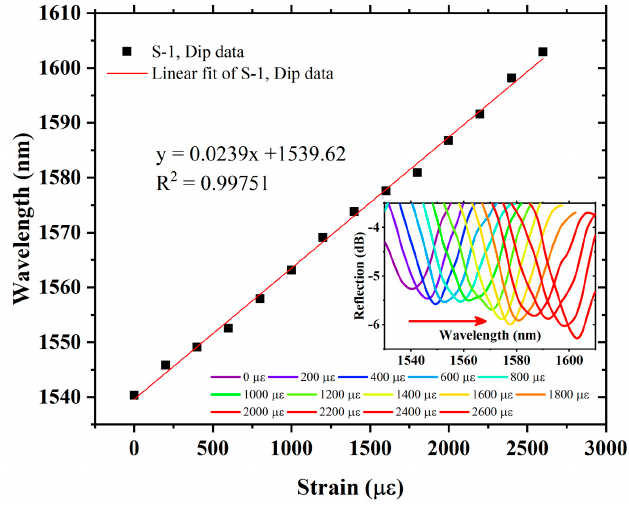
Figure 9. Sensitivity and linear correlation function of S-1, and inset exhibits spectral evolution of envelope dip data.